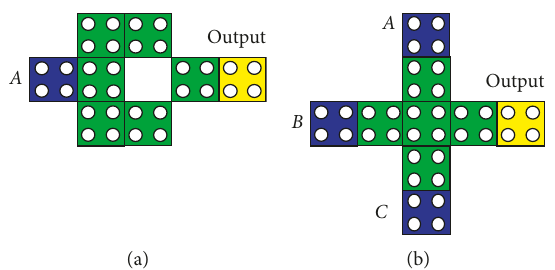
Figure 3: Inverter gate (a) and majority gate (b).